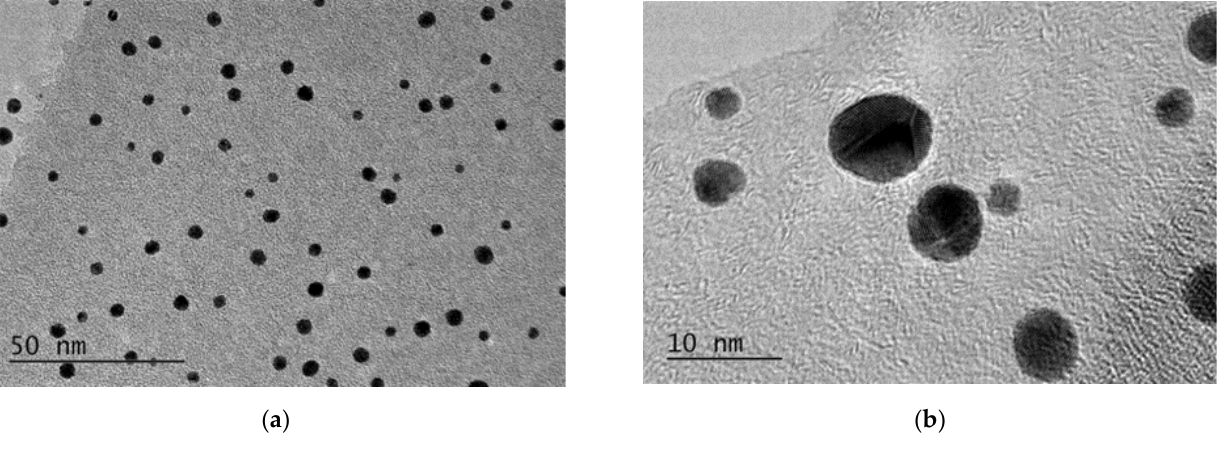
Figure 3. ( a ) TEM and ( b ) HRTEM micrographs of SA-AuNPs.